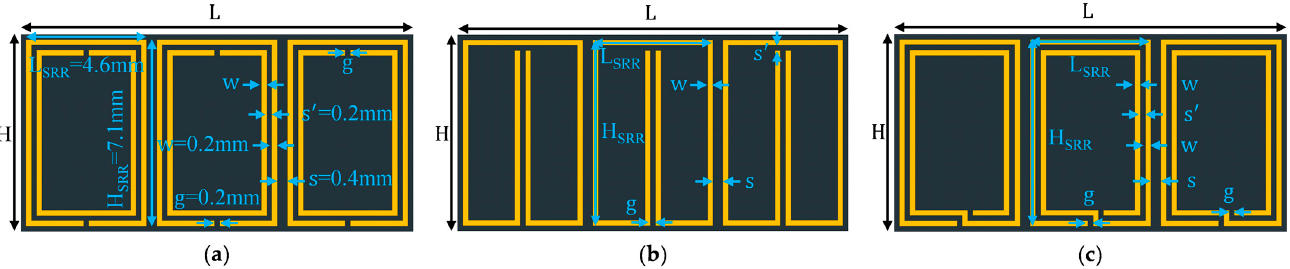
Figure 4. Host substrate with 3 x × 3 y × 1 z arrays of modified SRRs: ( a ) complimentary SRRs (CSRRs); ( b ) SRRs with extended arms (ESRRs); ( c ) spiral SRRs (SSRRs) ( Host substrate (L = 15 mm, H = 7.5 mm); Modified SRRs. Ground plane and probe are not shown.